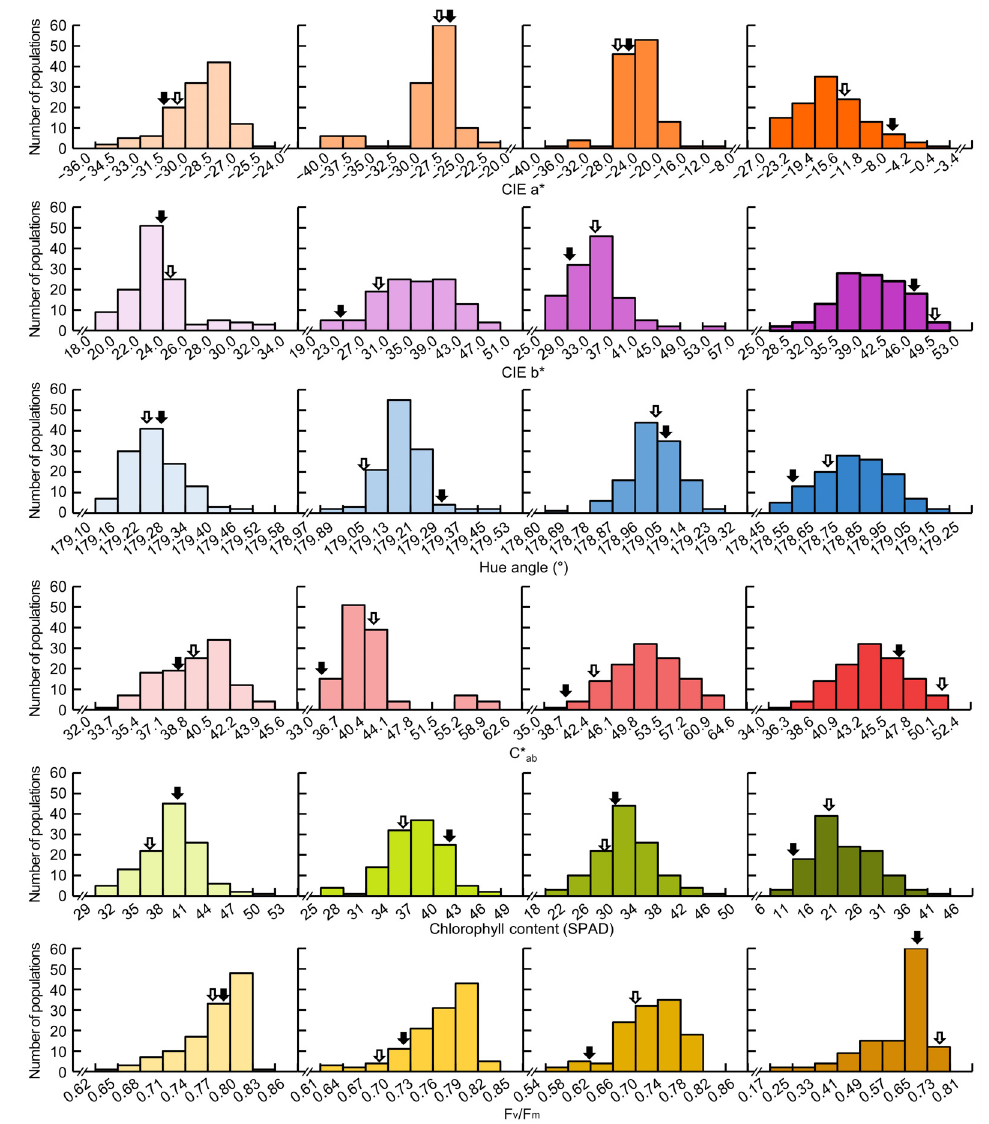
Figure 1. The frequency distribution for CIELAB values, chlorophyll content, and F v /F m in 120 Cheongcheong/Nagdong double haploid (CNDH) line. All traits showed normal distribution at 0, 15, 30, and 45 DAH, indicating that the traits are quantitative traits. Black arrow represents Cheongcheong and white arrow represents Nagdong. Table 2. Analysis of correlation between leaf color, chlorophyll content, and F v /F m in CNDH line.